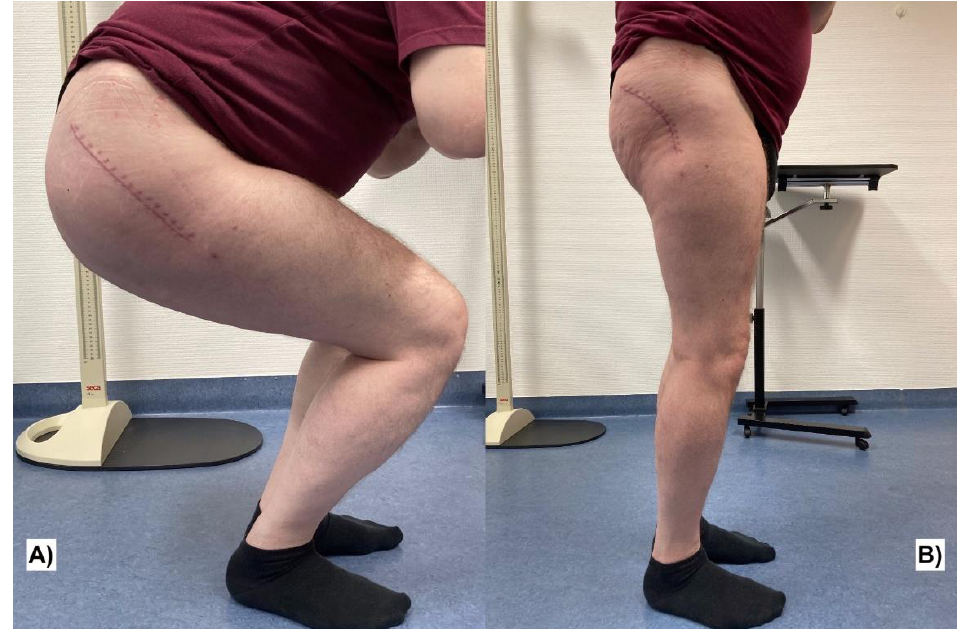
Figure 5. Documentation of the surgical scar and the function of the hip joint one year postoperatively. Squatting position ( A ) and standing upright ( B ).